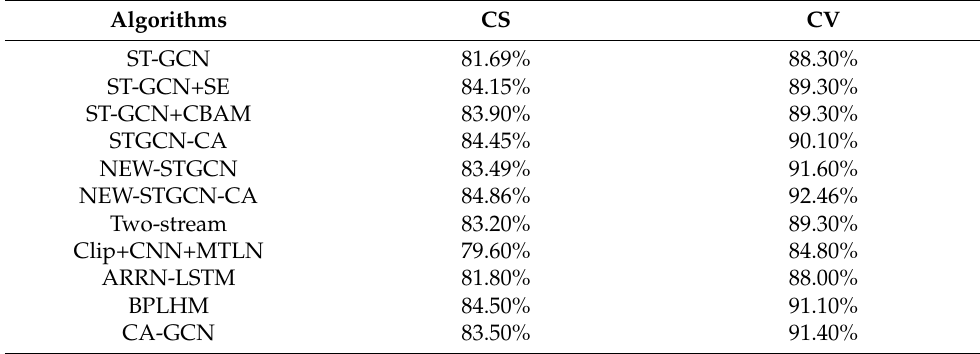
Table 1. Experimental results on the NTU-RGB+D 60